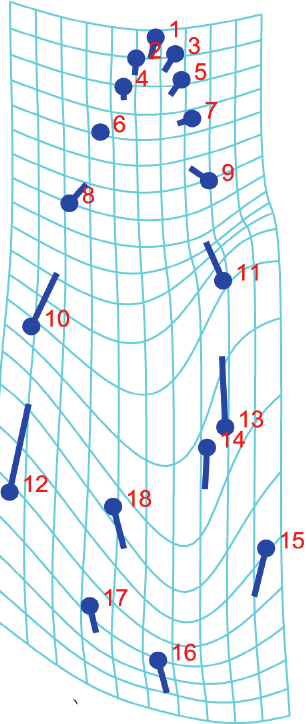
Figure 11. Shape changes along the CV1: the shifts of landmark positions are indicated by straight lines. Each line starts with a dot at the location of the landmark in the starting shape (i.e. Dianella schlickumi ). The length and direction of the line indicate the movement of the respective landmark towards the final shape (i.e. Dianella thiesseana